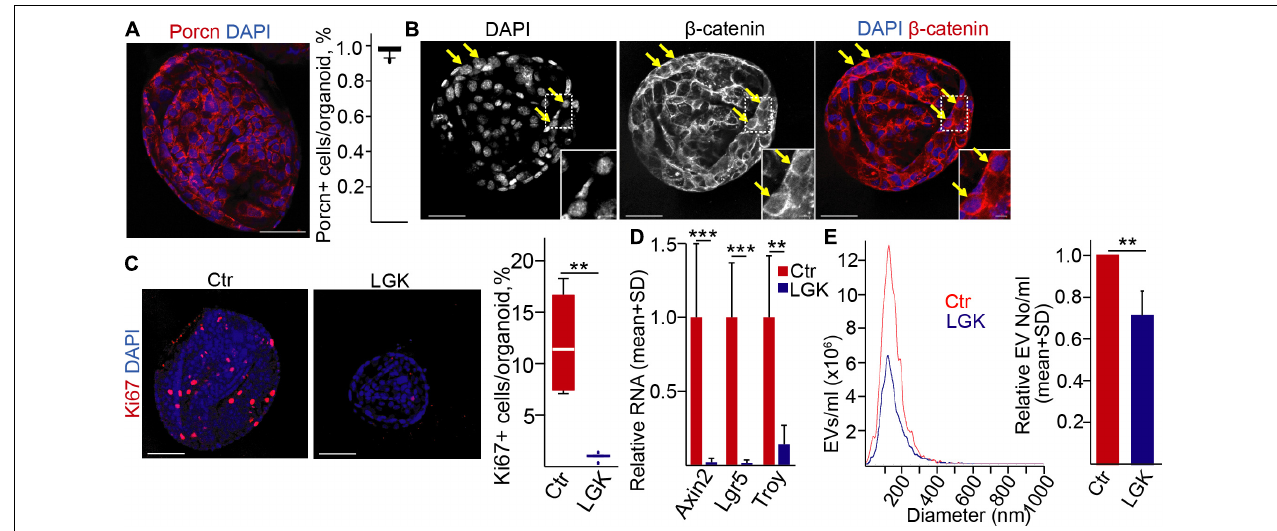
FIGURE 1 | Wnt secretion affects extracellular vesicle release in normal mouse pancreatic ductal (PD) organoids. (A) Immunostaining for porcupine (PORCN) and quantification of confocal microscopic images. (B) β -catenin detection in PD organoids (confocal microscope). The arrows mark cells with nuclear β -catenin. (C) Immunostaining for the proliferation marker Ki67 in the presence (LGK974) or absence (Ctr) of a PORCN inhibitor. Representative confocal microscopic images (left panels) and their quantification. (D) The relative RNA levels of Axin2 , Lgr5 , and Troy after treatments with LGK974 (RT-qPCR, n = 6). Data normalized to Hprt1 housekeeping were compared to the untreated control. (E) Representative images of nanoparticle tracking analysis (NTA) measurements (left panel) and their quantification (right panel, n = 5). Data were normalized to 10 6 cells and then compared. For panels (A,C) , 15–20 images from three experiments were analyzed. Kruskal–Wallis with Dunn post hoc test (C) , t -test (D) , or one-sample t -test (E) were used with ** p < 0.01, and *** p < 0.005. Scale bars: 50 µ m (A–C) or 10 µ m [ (B) magnified